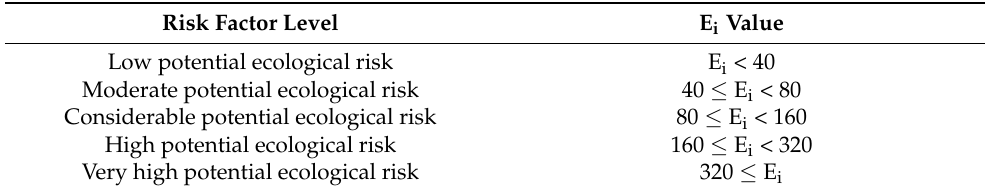
Table 5. Classification for the Potential Ecological Risk Factor (E i )